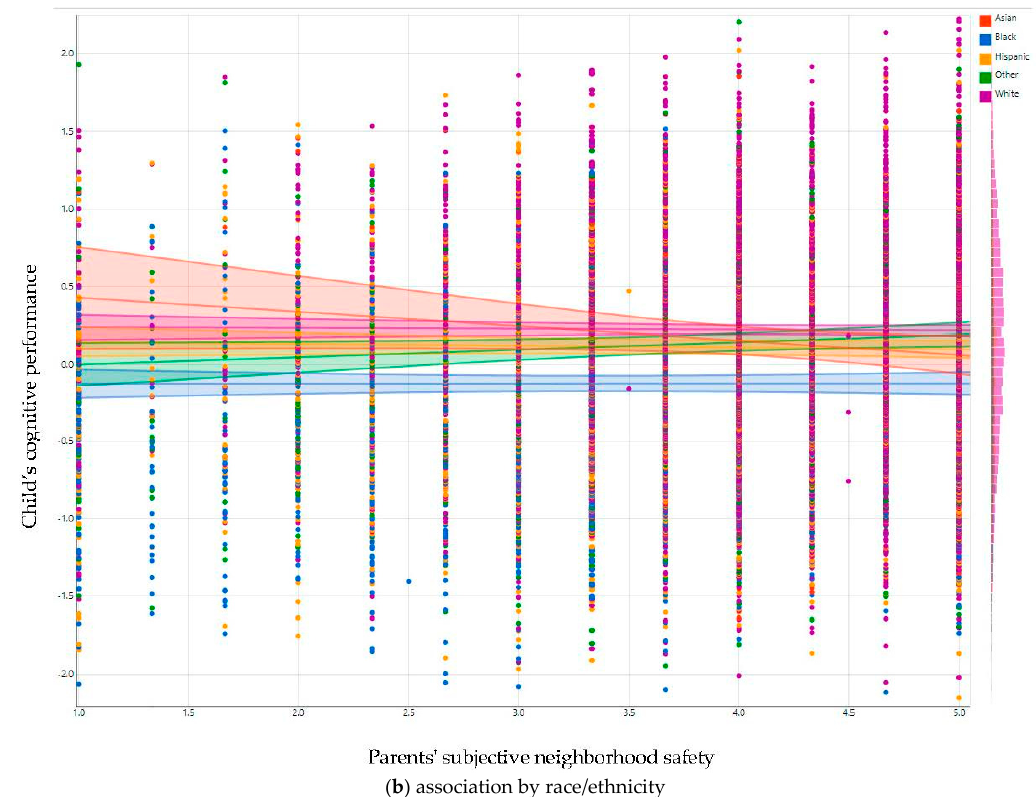
Figure 3. Association between parents’ subjective neighborhood safety and children’s learning/memory overall and by race/ethnicity.